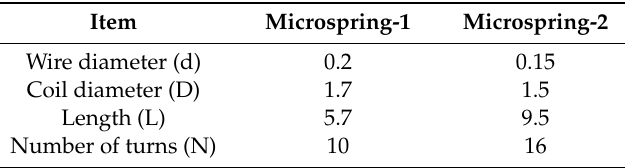
Table 2. Geometry and dimensions of two micro-springs.